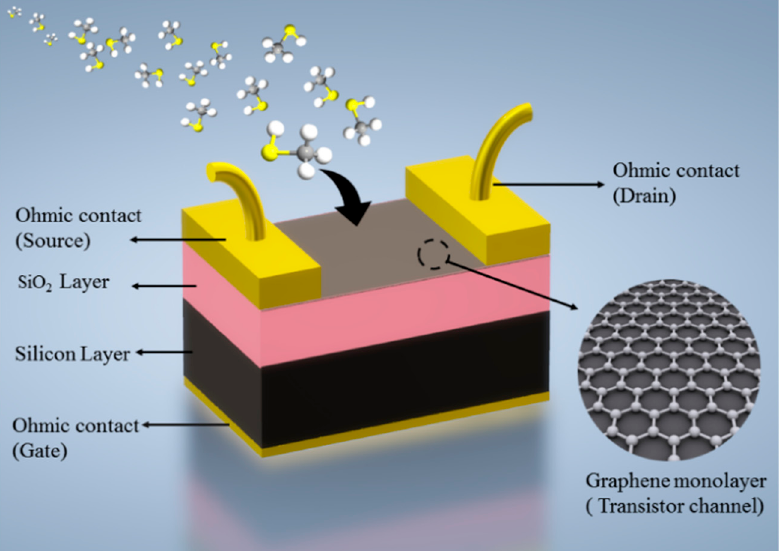
Figure 1. The proposed graphene field effect transistor (GFET) model. The back-gate structure enables binding of the biomarker to the channel surface.